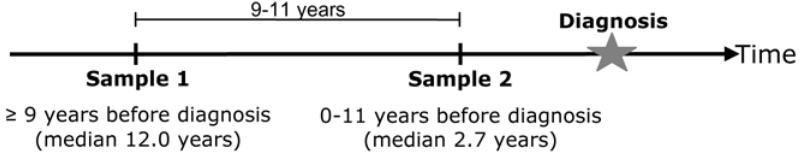
Figure 6. Schematic drawing of blood draws for sample 1 (baseline) and sample 2 (follow up).